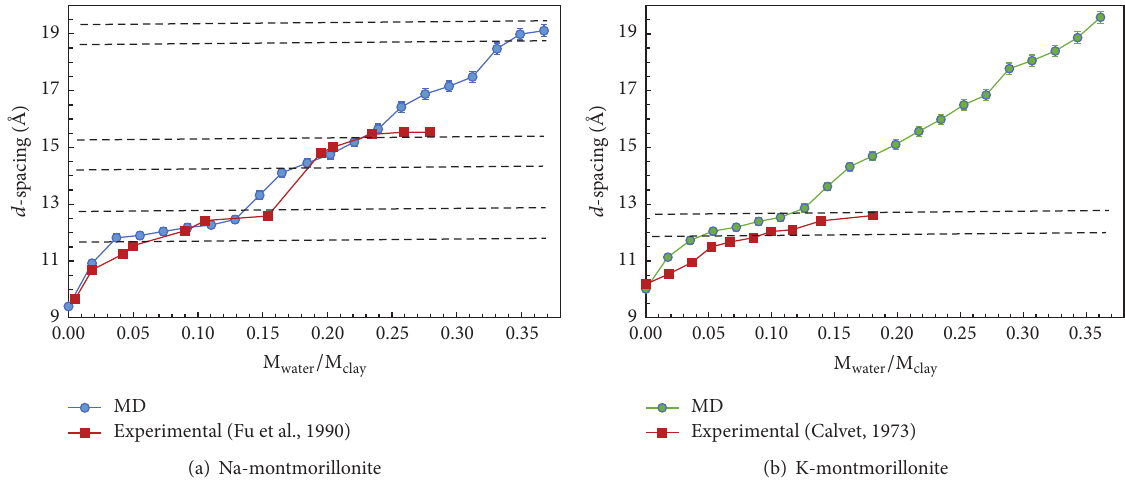
Figure 3: Swelling behavior of montmorillonite clays upon hydration. Comparison of calculated and experimental results.